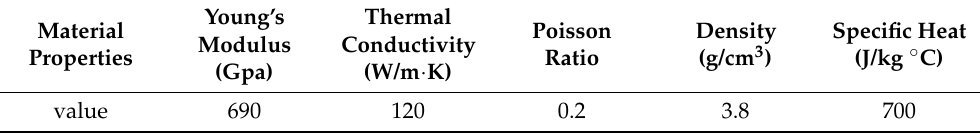
Table 1. CBN tool material performance parameters